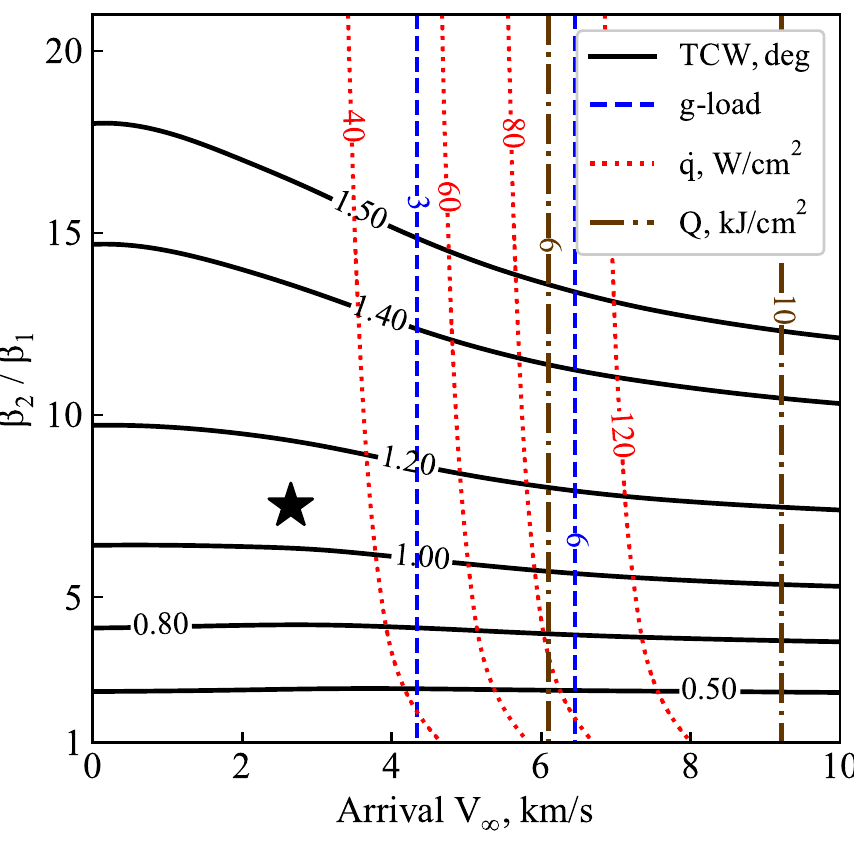
Figure 5. Mars drag-modulation aerocapture feasibility chart with β 1 = 20 kg/m 2 , R N = 0.235 m, target apoapsis = 2000 km. The star indicates the selected baseline β 2 / β 1 = 7.5 and V ∞ = 2.65 km/s.